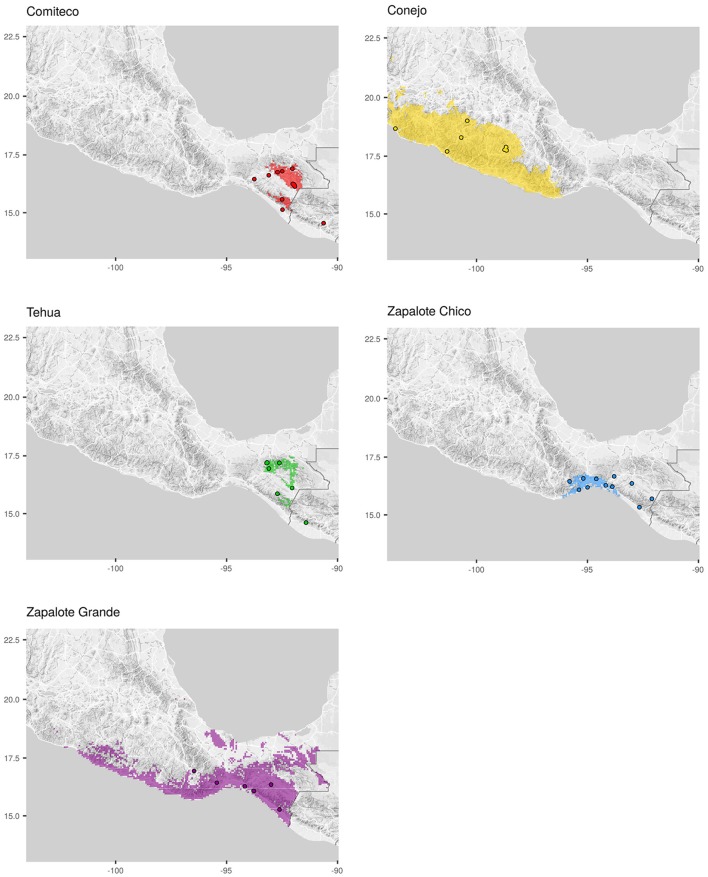
Sample collection sites. Each map shows the potential distribution of the maize landrace (shadowed area) and the location where the genotyped accessions of each landrace were collected (dots). Landrace potential distributions were taken from Perales and Golicher (2011).